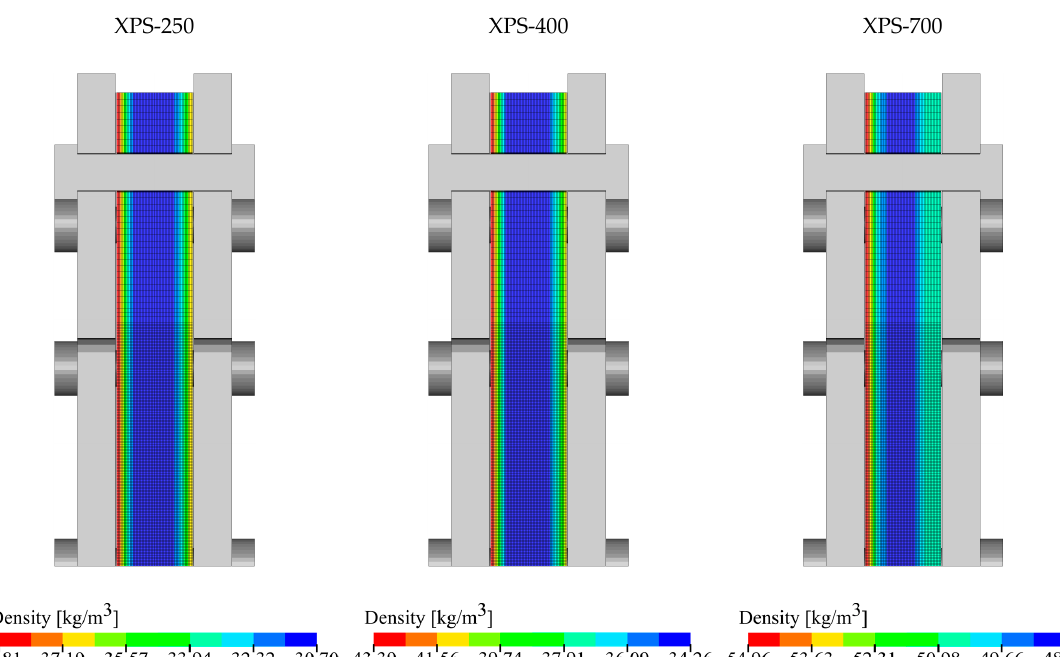
Figure 16. Visualisation of the density distribution as applied in the numerical models. The blast load was applied to the exposed area of 300 mm × 300 mm of the front skin as a tabulated pressure-time curve based on experiments using massive plates [26]. Pressure-time histories, as measured by pressure sensors mounted on the surface of massive steel plates, were fitted to the Friedlander equation given as